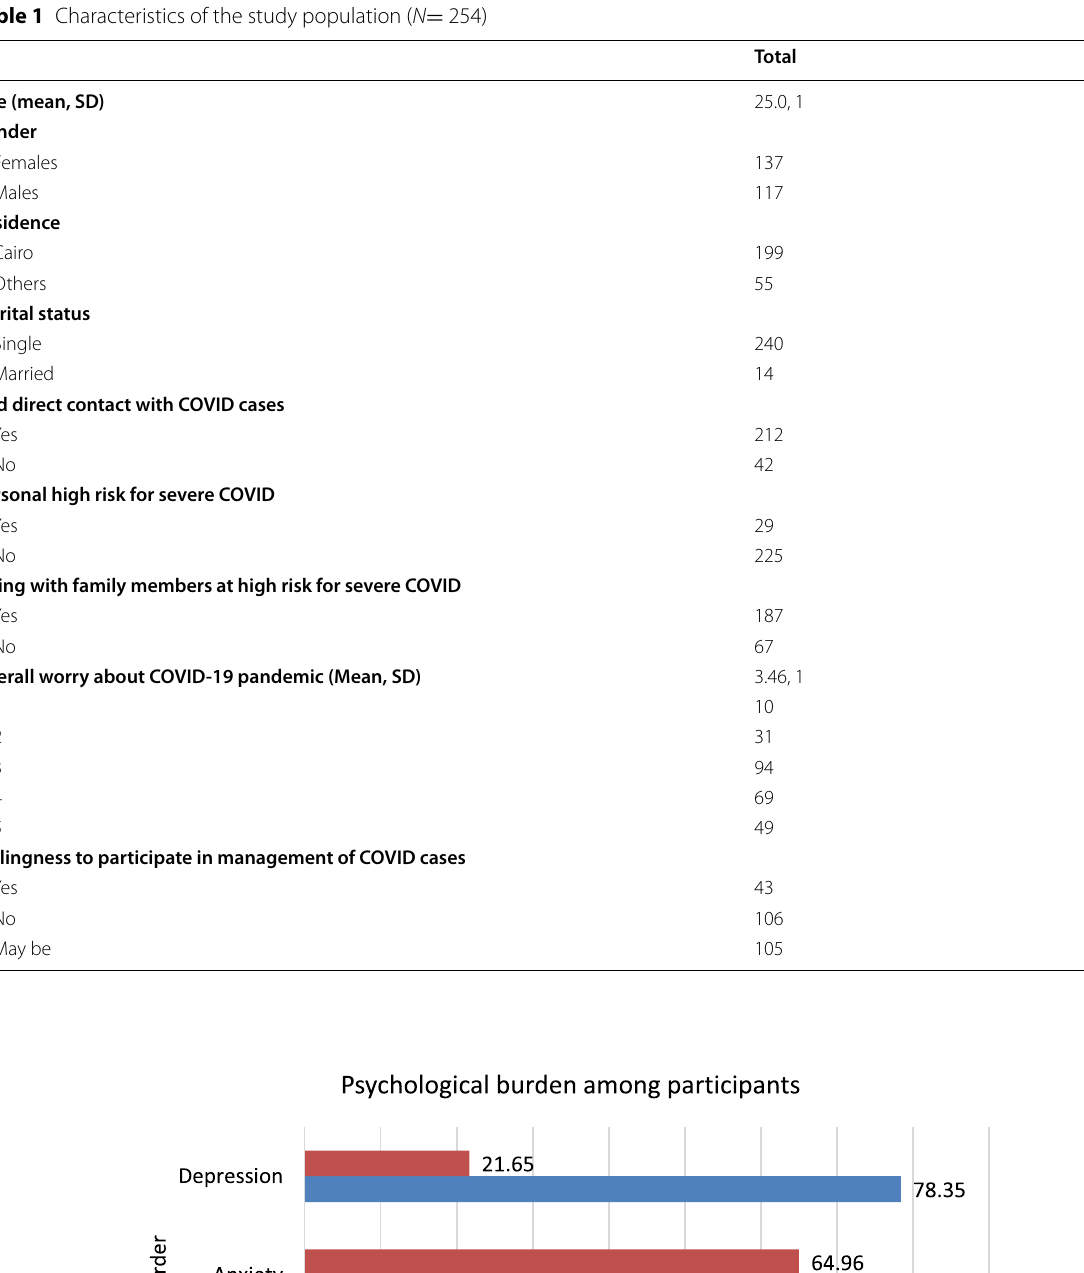
Table 1 Characteristics of the study population ( N